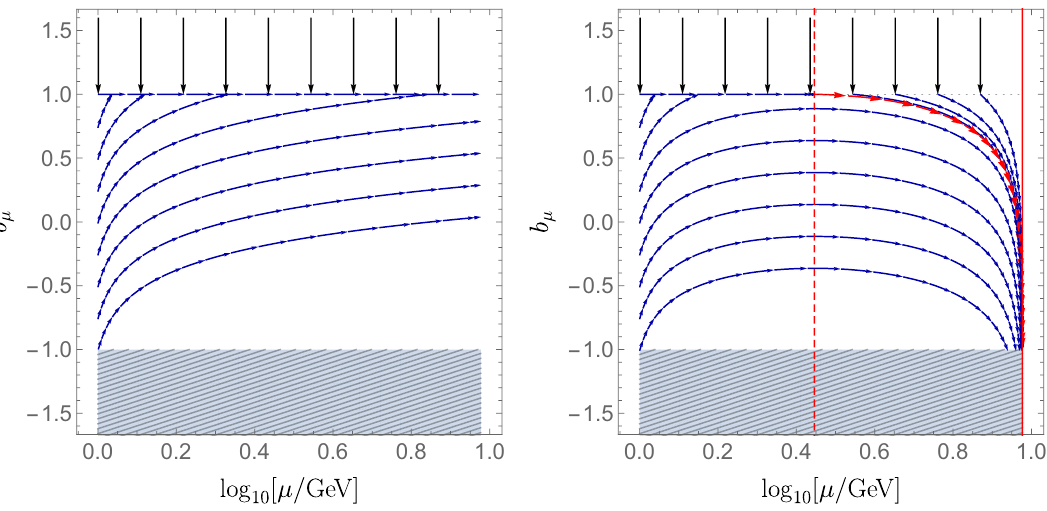
Figure 2 . RG flow of the exponent b µ in QCD-only (left), and QCD × QED (right). For illustration purposes, these curves are obtained with α ( µ ) = 4 π , α ( µ ) = π/ 4 at the initial scale µ = s 0 em 0 0 1 GeV, with β QCD = 29 / 3 and β QED = − 32 / 9 , which corresponds to a theory with one generation 0 0 of quarks and leptons. The solid vertical red line in the right panel marks the Landau pole of the QED coupling at µ 9 . 5 GeV, and the dashed vertical red line the critical scale defined by (4.20) L ≈ at µ 2 . 8 GeV. Lastly, for every function defined at scales below µ , the exponent b remains c ≈ c µ below the red curve. In particular, for every such function there is a maximum scale of well-defined evolution before it is pushed to the critical region b = − 1 (shaded gray) where the RG equation µ is